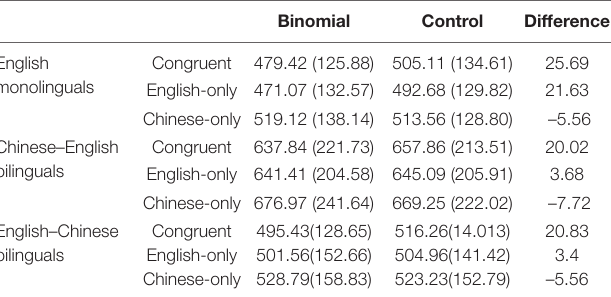
TABLE 4 | Descriptive statistics: mean response times in ms (standard deviations) and difference between mean response times to the binomial and control phrases for English monolinguals, Chinese–English, and English-Chinese bilinguals in each of the six experimental